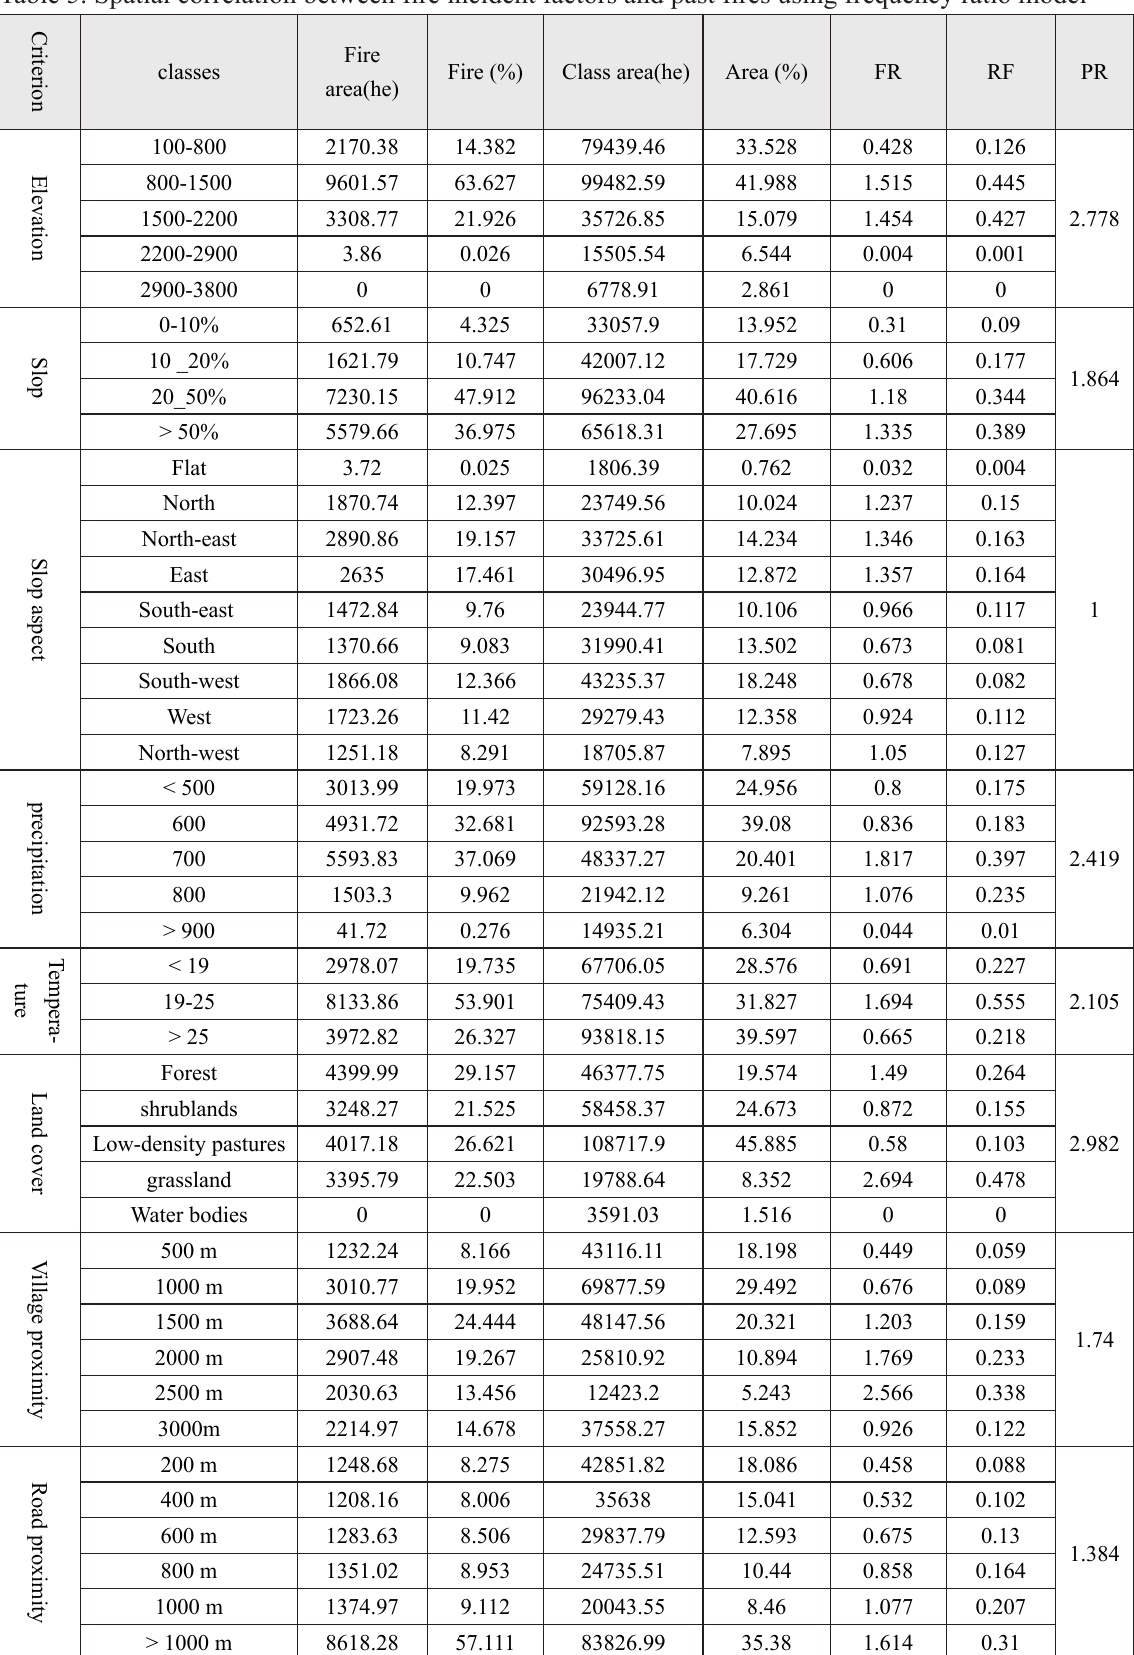
Table 5. Spatial correlation between fire incident factors and past fires using frequency ratio